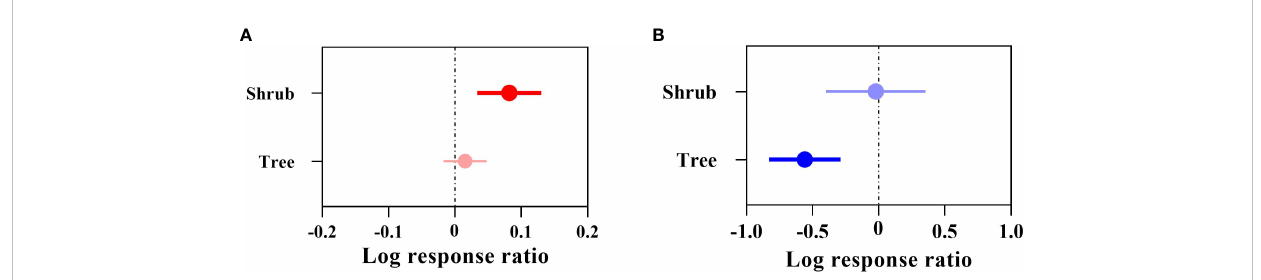
FIGURE 4 Effect sizes of the types of Chinese woody plants. (A) indicates the overall suitable area, and (B) indicates the highly suitable area. The effect of future climate on the overall/highly suitable area (main effects) for different woody plant types is indicated. Error lines indicate 95% con fi dence intervals. Positive effect (red color), signi fi cant positive effect (bright red color), negative effect (blue color), and signi fi cant negative effect (bright blue